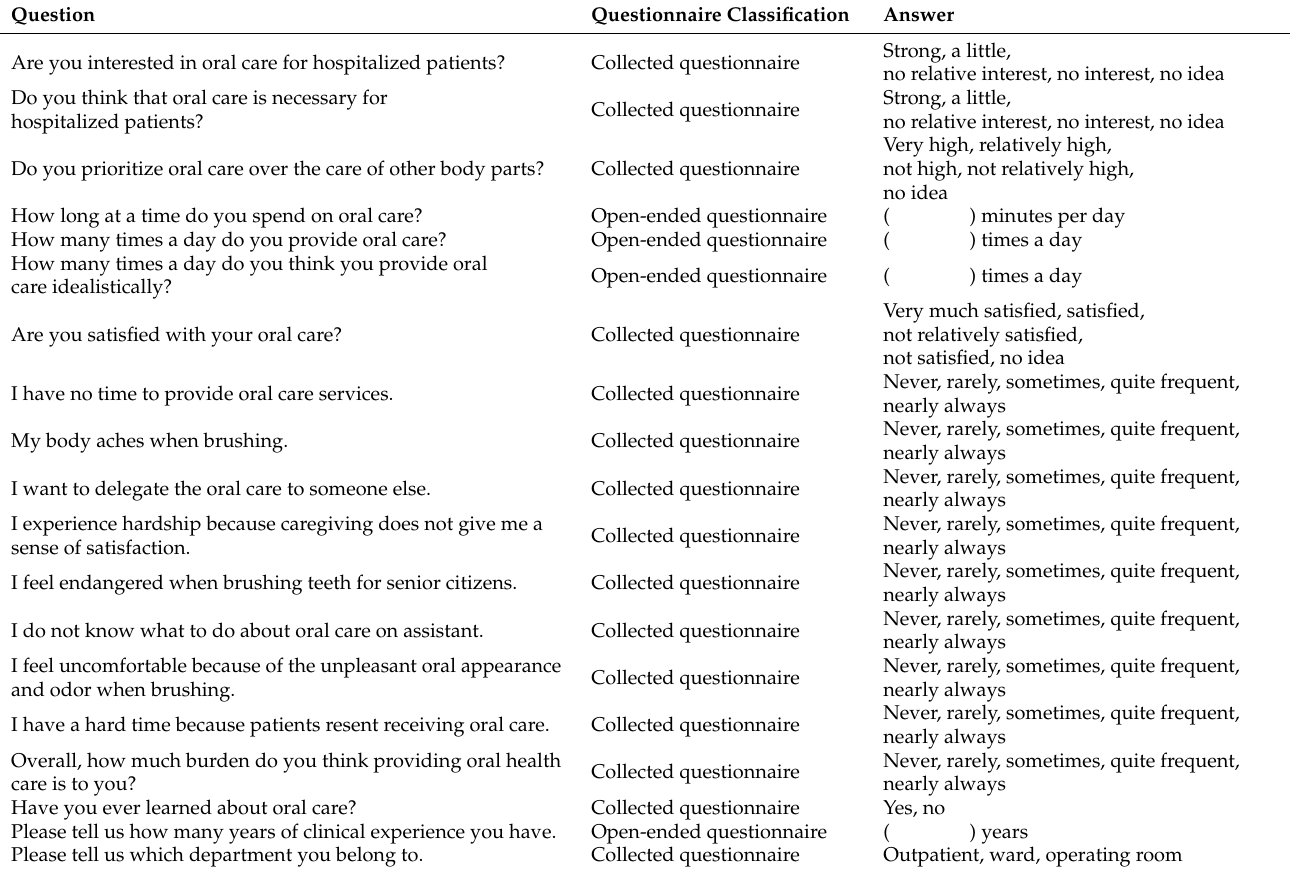
Table 1. Questionnaire